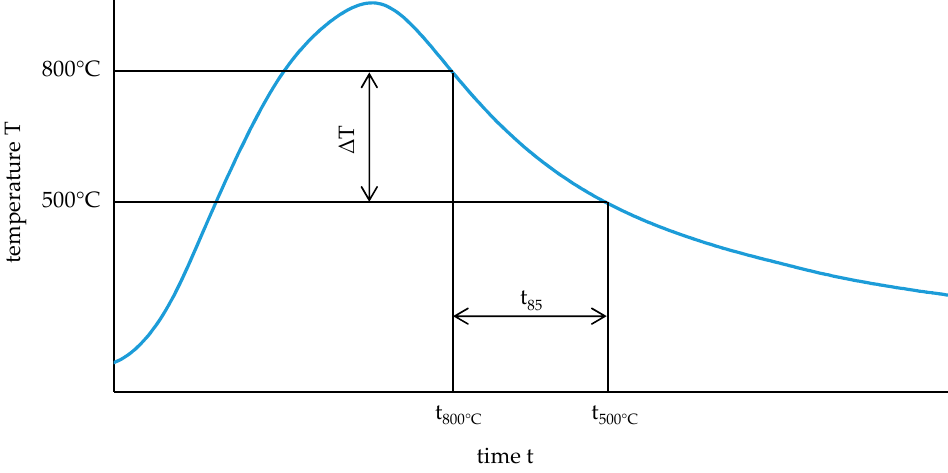
Figure A1. The exemplary analysis temperature plot and the definition of the quenching time t 85 .